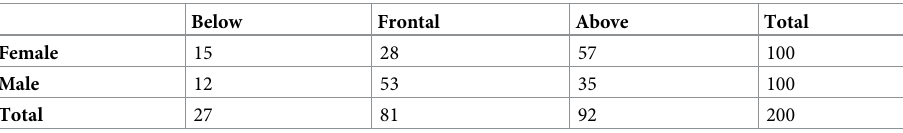
Table 2. Frequencies of individual dominant poses in female and male